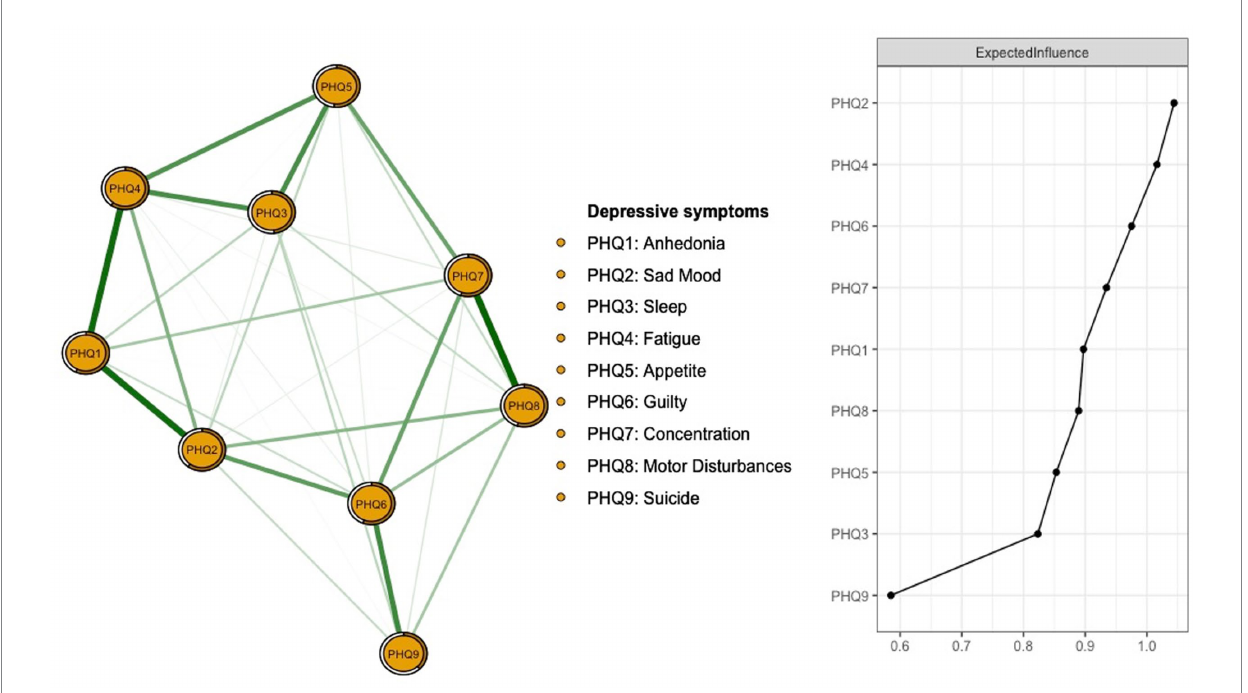
FIGURE 1 Network structure of depressive symptoms among Macau residents during the 618 COVID-19 wave. Number of nodes: 9; Number of non-zero edges:35/36; Mean weight: